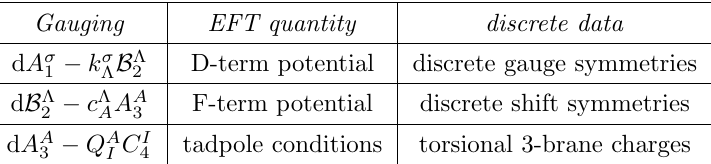
c (cid:3) = c (cid:3) Q A = 0 are satis(cid:12)ed. (cid:3) A A I